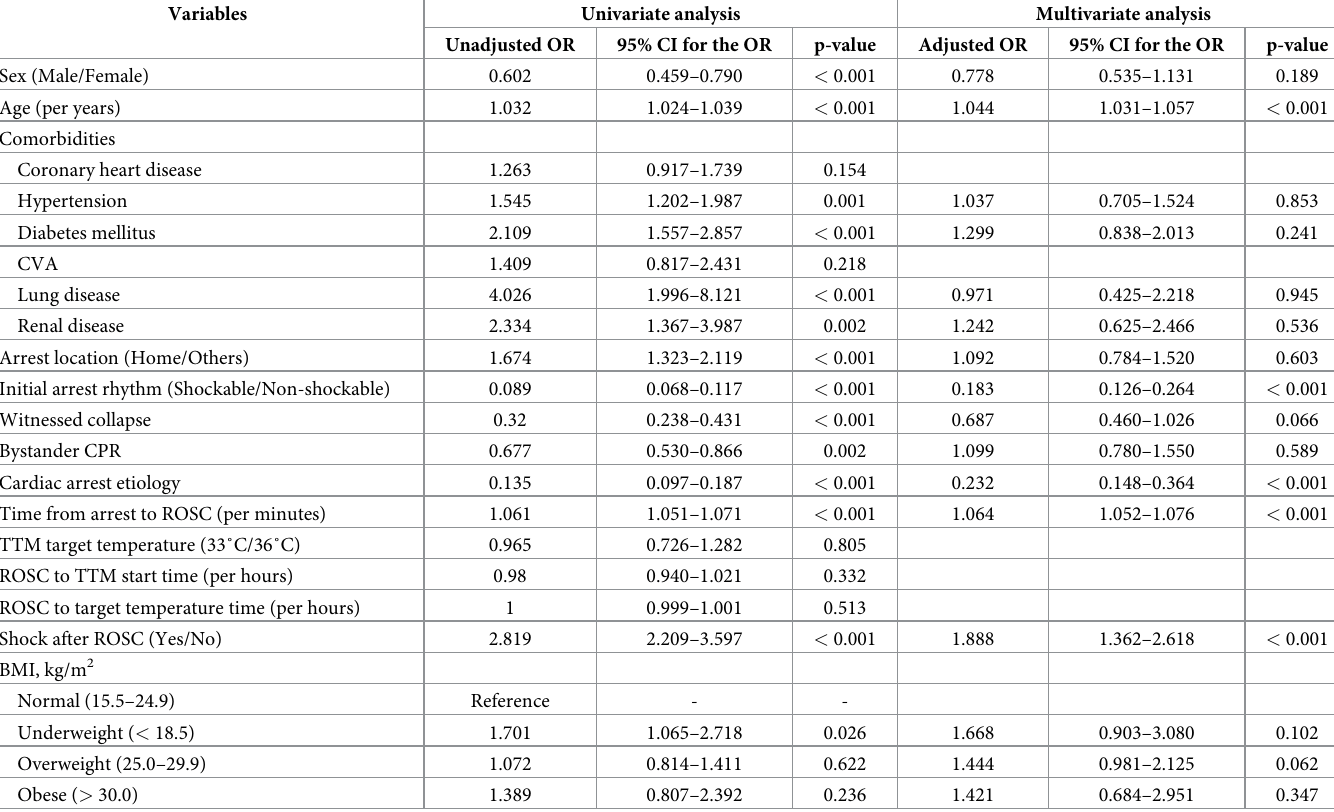
Table 2. Univariate and multivariate logistic regression analysis for poor neurologic outcome at 6